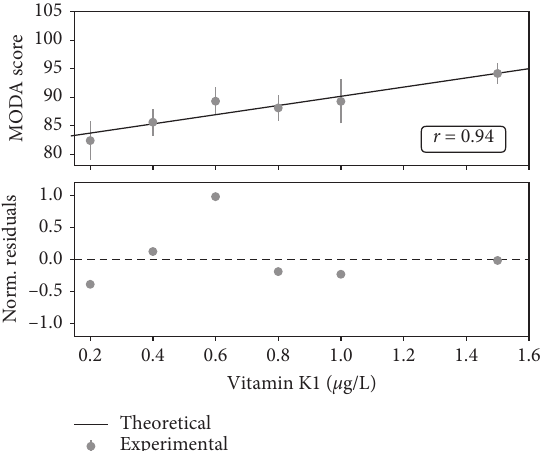
Figure 2: Analysis of MODA scores vs. vitamin K1 levels after binning the data. The linear relationship between MODA scores and vitamin K1 plasmatic levels appears clear after binning the data according to vitamin K1 concentration bicentiles. The value of χ 2 ] of 0.3 is not << 1 thus suggesting that we should not reject the null hypothesis of a linear relationship between vitamin K1 levels and MODA scores. This is supported by the normalised residuals being randomly distributed around the zero and not showing any clear structures. The value for the Pearson correlation coefficient of 0.94 shows a very high positive correlation between MODA scores and vitamin K levels, thus further confirming that the linear regression is a good model for the